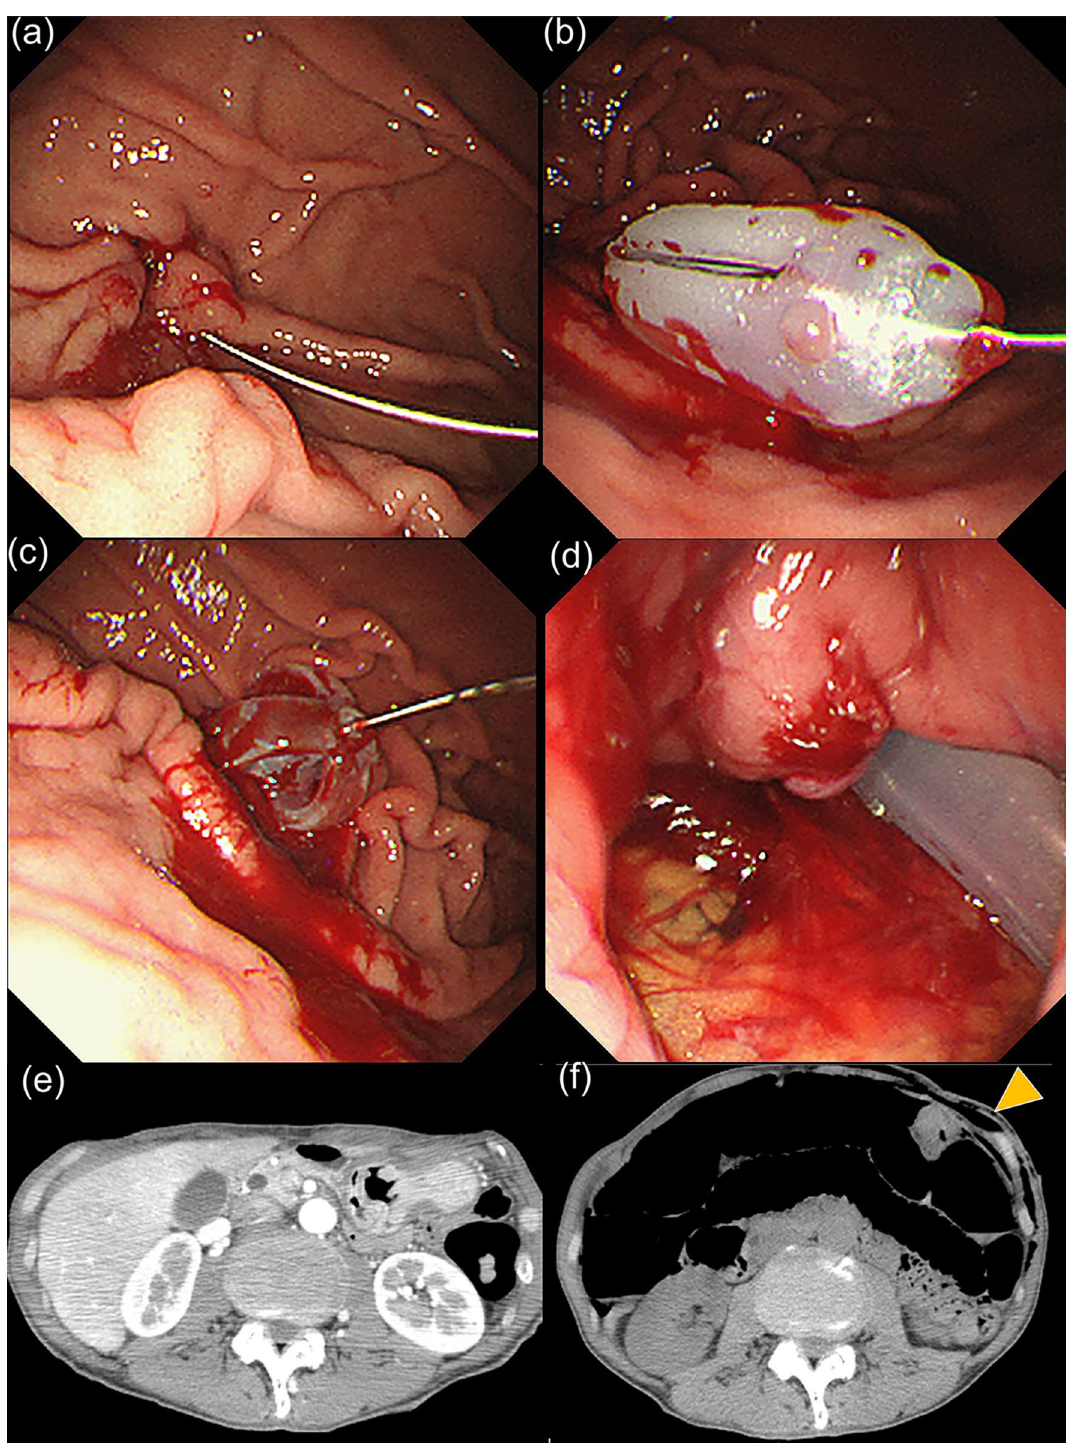
Figure 3. Endoscopic and CT images before and after PEG construction in case 2. ( a ) Three-point gastric wall fixation was performed near the PW of the GC. ( b ) As it was difficult to insert the dilator, a skin incision was added for placement of the gastrostomy tube into the stomach. ( c ) Bleeding occurred immediately after the procedure. ( d ) Gastric perforation was detected. ( e ) Before PEG construction, there was no intestinal interference between the stomach and abdominal wall. ( f ) After discontinuing PEG construction, there was free air in the abdominal cavity and subcutaneous emphysema in the abdominal